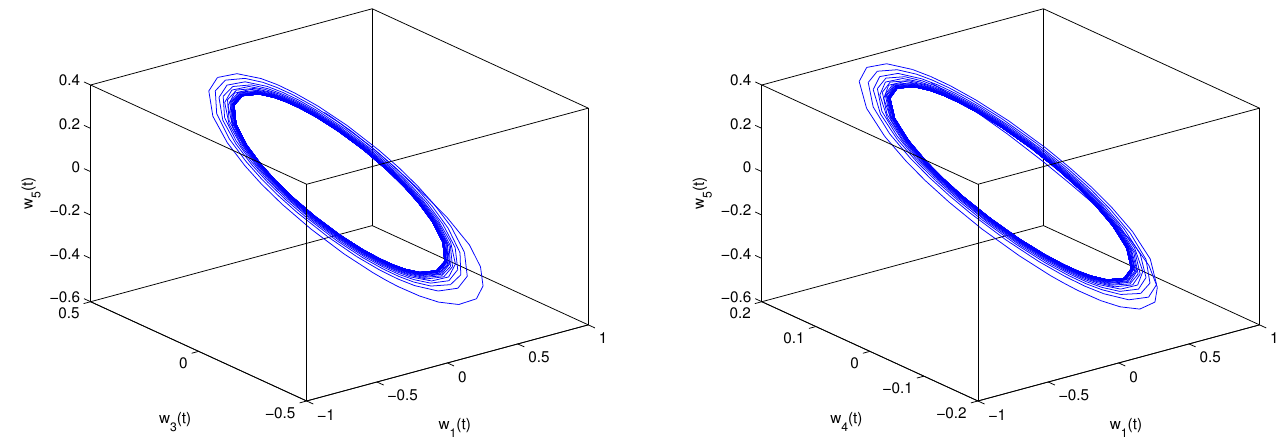
Figure 9. Matlab simulation outcomes for system (72) when ϑ = 0.5 > ϑ ∗ = 0.44. System (70)